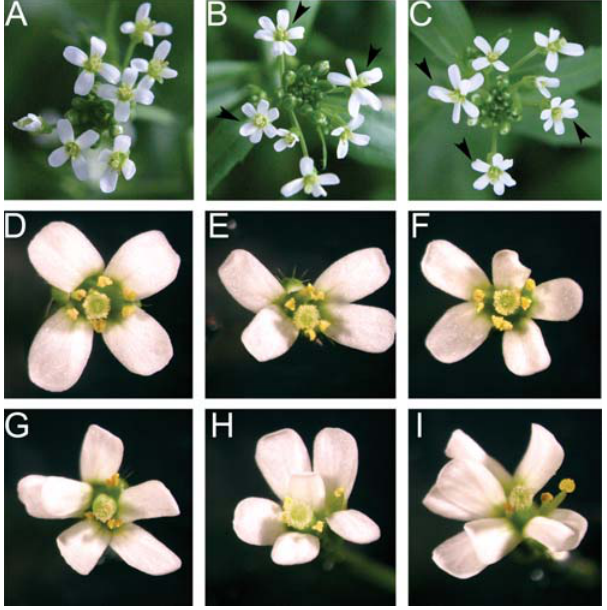
Figure 7. sr45-1Flowers have Altered Number of Sepals and Petals. (A) WT inflorescence shows that all flowers had four petals. (B and C) Inflorescences from two separate sr45-1 plants are shown. Each panel shows 3 of 6 flowers with abnormal petal and stamen numbers, indicated by arrowhead. (D) Close-up of a WT flower with 4 petals 6 stamens. (E–I) sr45-1 flowers with abnormal petal and stamen numbers. Number of sepals and carpels were not changed. (E) 4 petals 5 stamens (F) 5 petals 5 stamens (G) 6 petals 3 stamens (H) 6 petals 4 stamens (I) 8 petals 3 stamens. doi:10.1371/journal.pone.0000471.g007 inset). The ectopic expression of GFP-SR45 in transgenic sr45-1